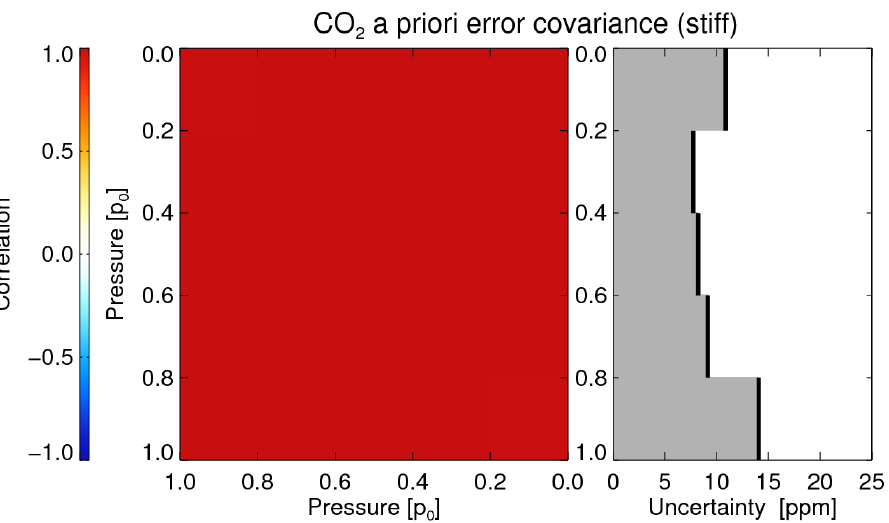
Figure 12. Same as Figure4 but for a synthetic a priori error correlation matrix as proposed by Reuter et al. [30] but with a correlation length of 100 p 0